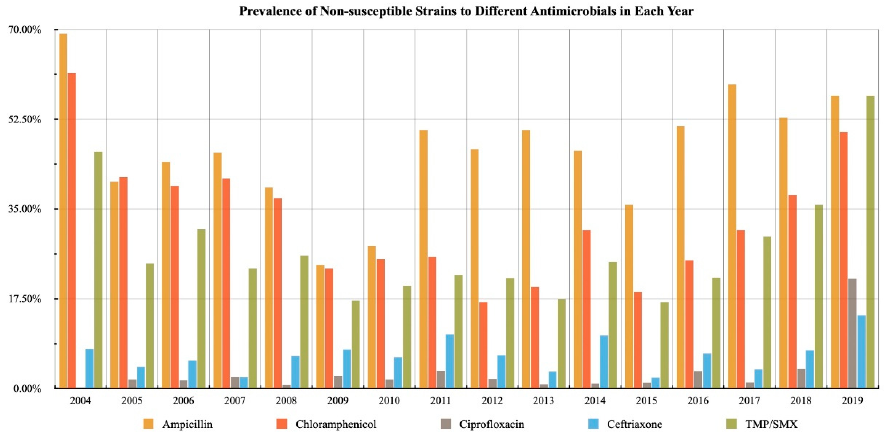
Figure 1. Prevalence of non-susceptible strains to different antimicrobials in each year. The differences of the prevalence of non-susceptible strains to each antimicrobial were further compared by dividing into two periods. The percentages of non-susceptible isolates to ampicillin showed a significant increase in period 2 compared to period 1 ( p = 0.000, 38.8% in period 1 vs. 48.6% in period 2). There were no significant differences in the prevalence of non-susceptible strains to ciprofloxacin, ceftriaxone and TPM/SMX between 2 periods.